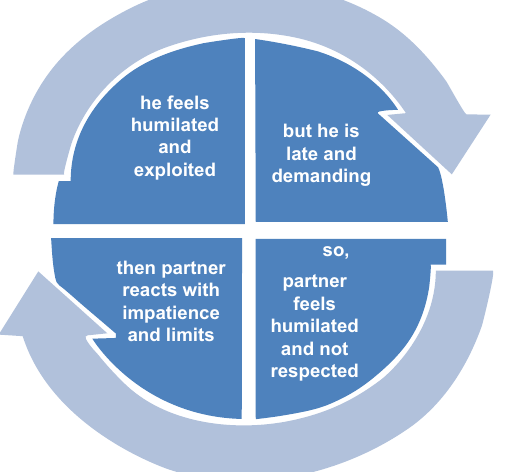
Figure 3. Mr. A’s dynamic relationship cycle – this maladaptive repetitive pattern of feelings and behaviors is mostly non conscious to Mr.